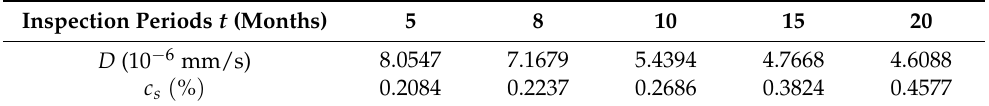
Figure 9. Distribution of free chloride and free sulfate contents versus the diffusion depth. ( a ) Free chloride, ( b ) Free sulfate. Table 6. Regression values of D and c s